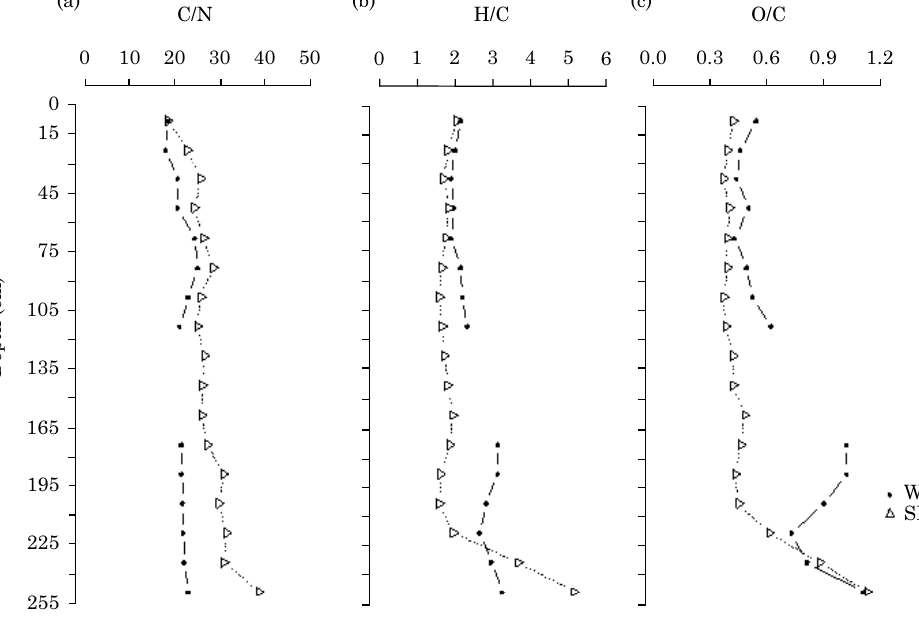
Figure 4. Ratios: (a) carbon/nitrogen (C/N), (b) hydrogen/carbon (H/C), (c) oxygen/hydrogen (O/H), and (d) oxygen/carbon (O/C) in depth in core samples under wet grassland (WGL) and semi-deciduous forest (SDF) from the peat in the headwaters of the Rio Preto.